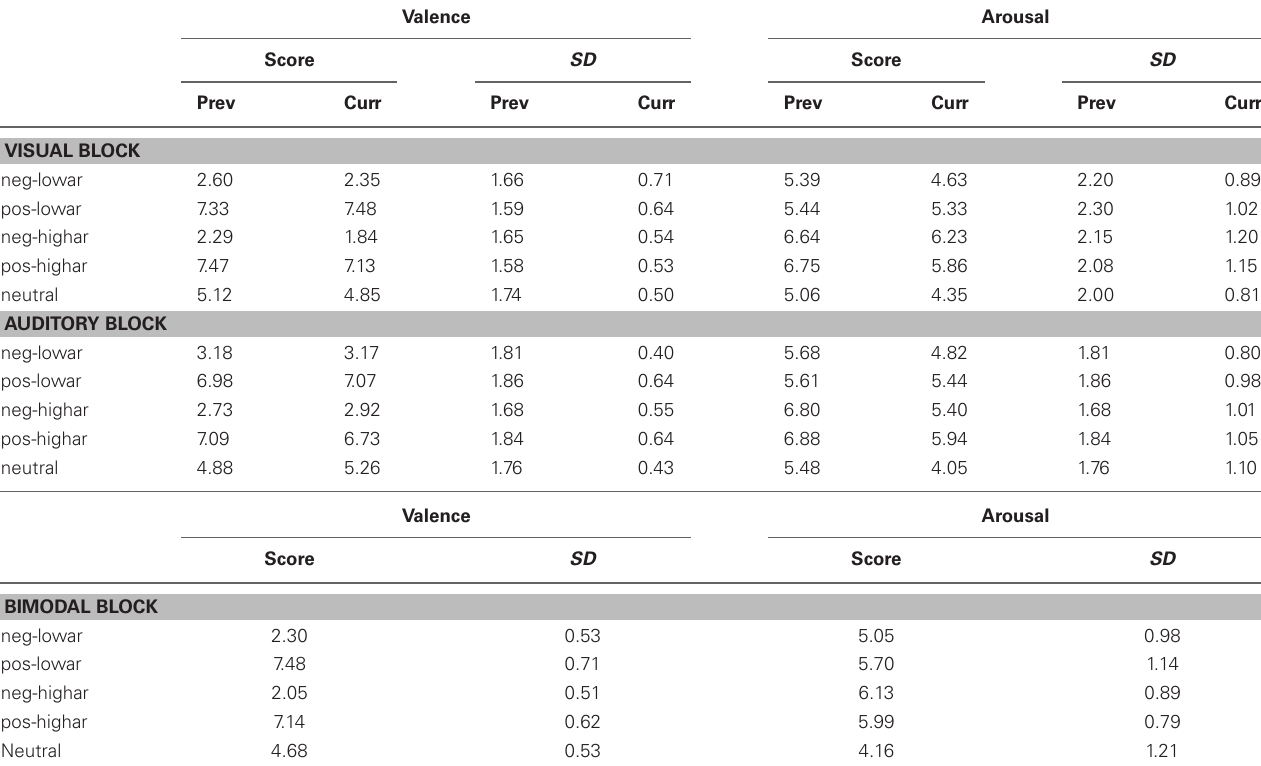
Table 2 | Valence and arousal scores with their standard deviations of stimuli used in each of the five emotional blocks as previously reported in the IAPS (Lang et al., 2005) and IADS (Bradley and Lang, 2007) documentation and as currently reported by our participants.